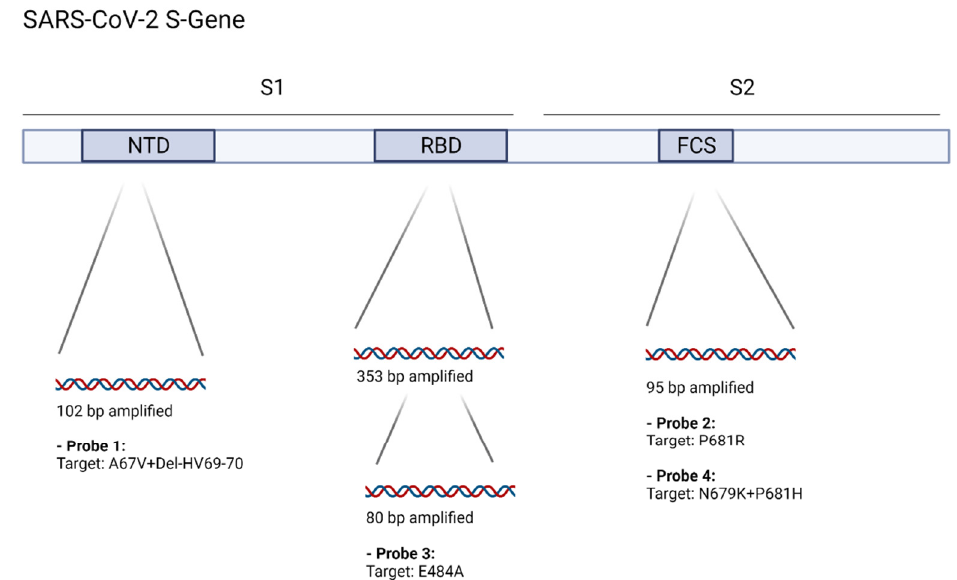
Figure 1. Target regions were chosen based on initial available Omicron variant sequences. The included primer sets are either still a 100% match or modified with ambiguous bases to amplify three target regions within the SARS-CoV-2 S-gene, containing deletions or SNPs in the Omicron variant. Four different LNA-Probes are used to specifically detect one or multiple sequence variances in order to allow classification. Delta variant sequences are expected to contain the P681R SNP (probe 2, “P681R”) but not the other tested variances. Omicron variant (Non-BA.2) sequences are expected to contain A67V + del-HV69-70 (probe 1, “SDEL2”), E484A (probe 3, “E484A”) and N679K + P681H (probe 4, “P681H”). The BA.2 lineage is expected to return negative for probe 1 but remain positive for the two other targets. NTD: N-terminal domain, RBD: receptor binding domain, FCS: Furin cleavage site. Image was created using Biorender software. All included oligos are listed in Table 1.